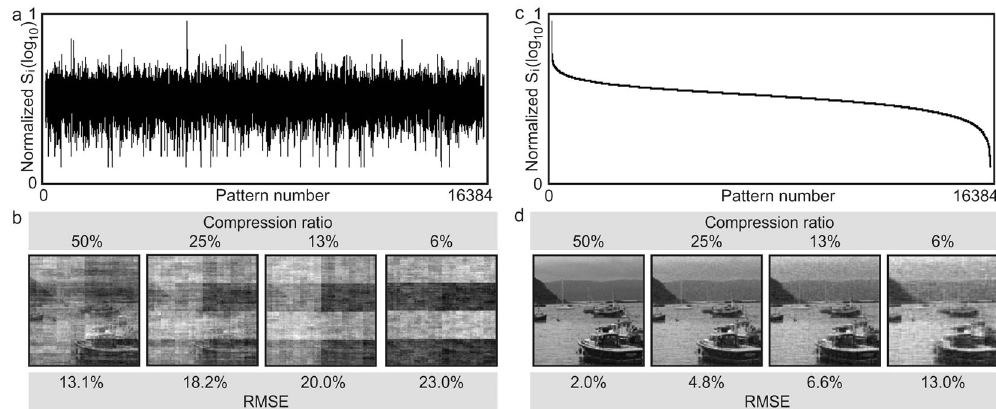
Figure 1. Image reconstruction with different fractions of the complete set of Hadamard patterns. ( a ) Decomposed intensities of 16384 randomly ordered Hadamard patterns. ( b ) Comparison of reconstructions using fractions of the complete set. ( c ) Intensities in descending order. ( d ) Reconstructions using the most significant fractions of the complete